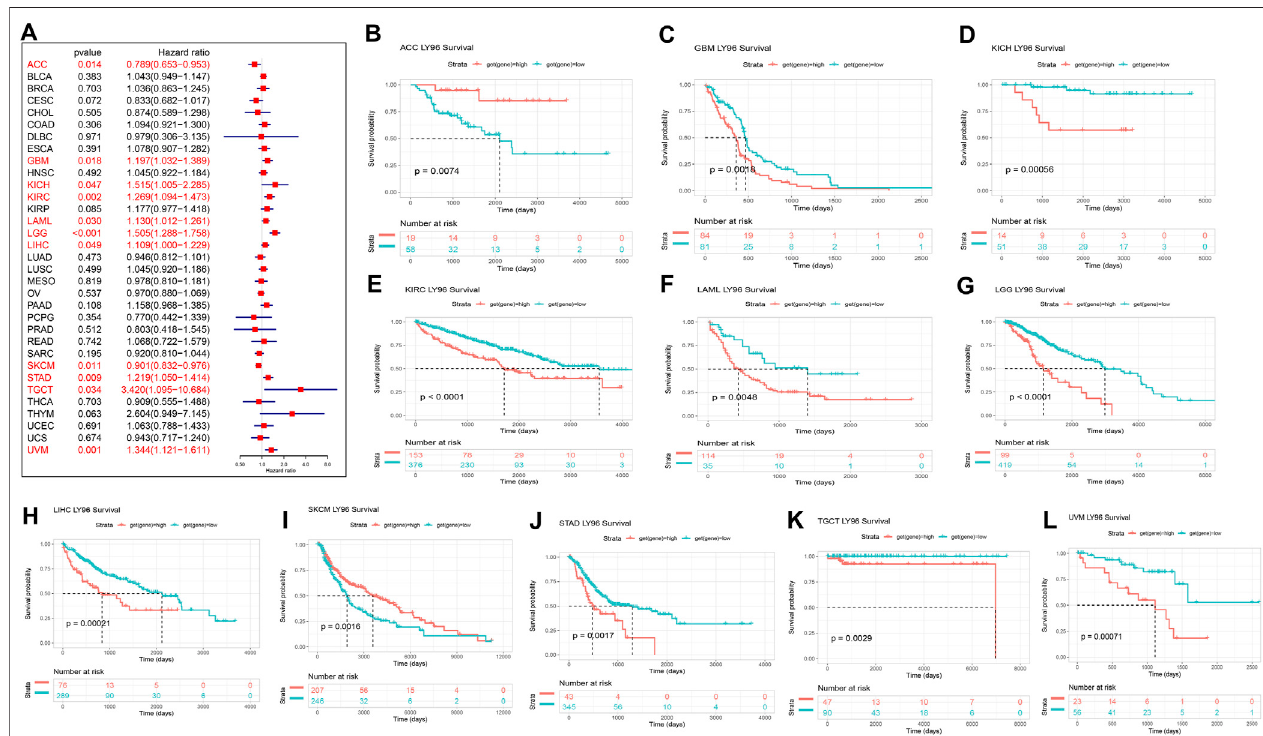
FIGURE 3 | Correlation between LY96 expression and overall survival (OS). (A) Forest plot of LY96 expression and OS across cancers. Kaplan – Meier analysis of LY96 expression and OS in (B) adrenocortical carcinoma (ACC), (C) glioblastoma multiforme (GBM), (D) kidney chromophobe (KICH), (E) kidney renal clear cell carcinoma (KIRC), (F) acute myeloid leukemia (LAML), (G) brain lower grade glioma (LGG), (H) liver hepatocellular carcinoma (LIHC), (I) skin cutaneous melanoma (SKCM), (J) stomach adenocarcinoma (STAD), (K) testicular germ cell tumors (TGCT), and (L) uveal melanoma